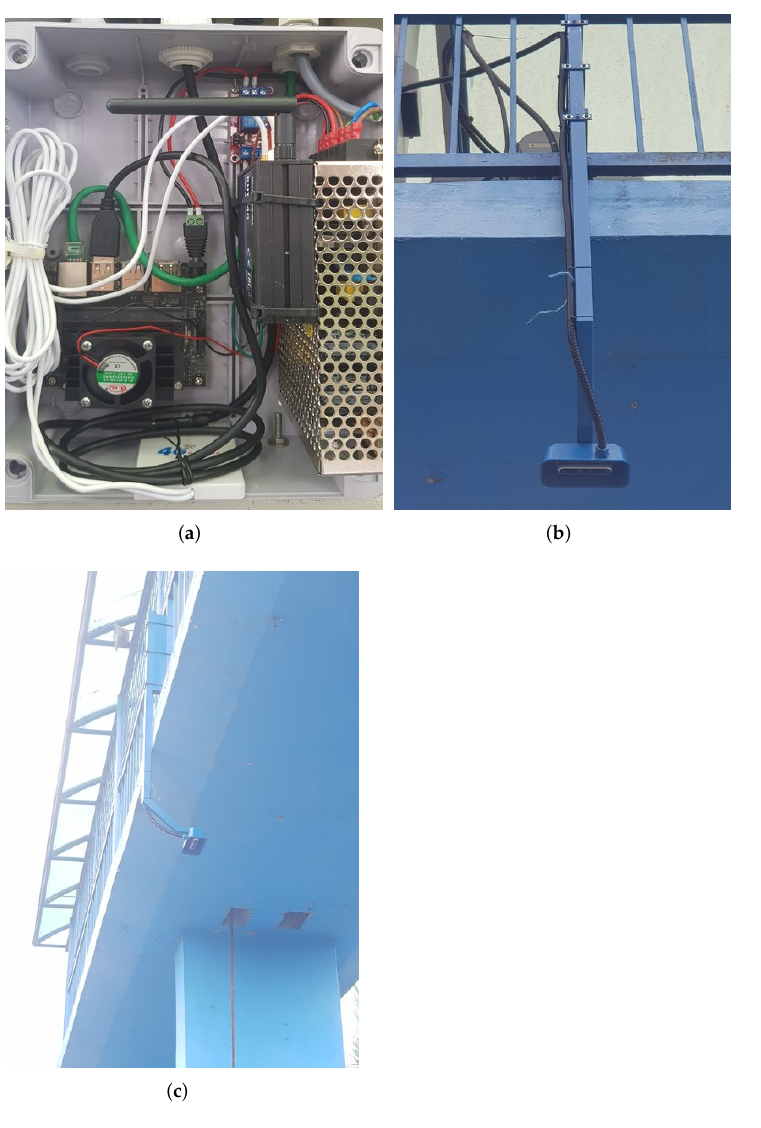
Figure 7. ( a ) The Jetson Nano enclosure which houses all the electrical components. ( b ) RealSense camera installation location. ( c ) Platform view of the installation site.